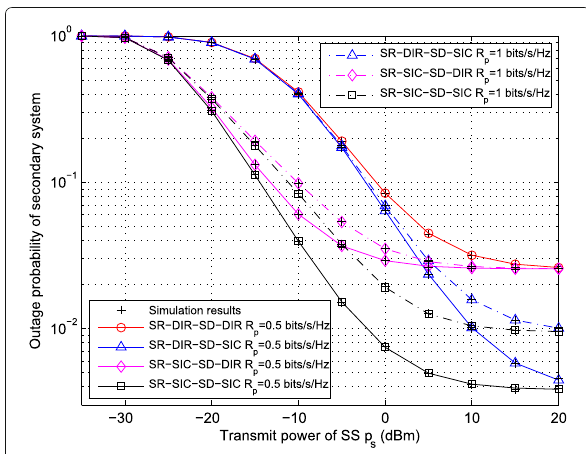
Fig. 7 Outage probability of secondary system vs the transmit power of SS